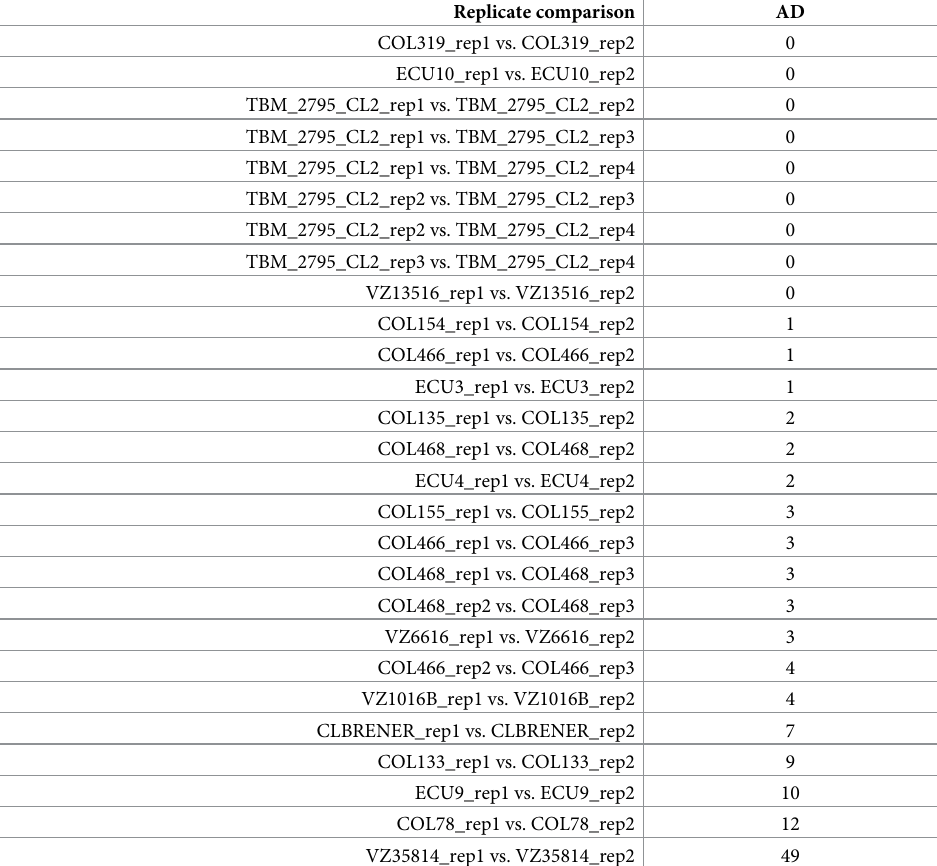
Table 2. Allelic differences between GLST replicates. Eighteen samples were processed in 2–4 replicates after DNA extraction. A single SNP locus can differ by 0, 1 or 2 between two replicates (i.e., replicates can match at both, one or neither allele). The AD measurement represents the total number of pairwise differences across all loci for which geno- types are called in all individuals (n = 561). The discrepancy between VZ35814 replicates likely represents barcode con- tamination with VZ16816 (see close similarity in Fig 4). Replicate